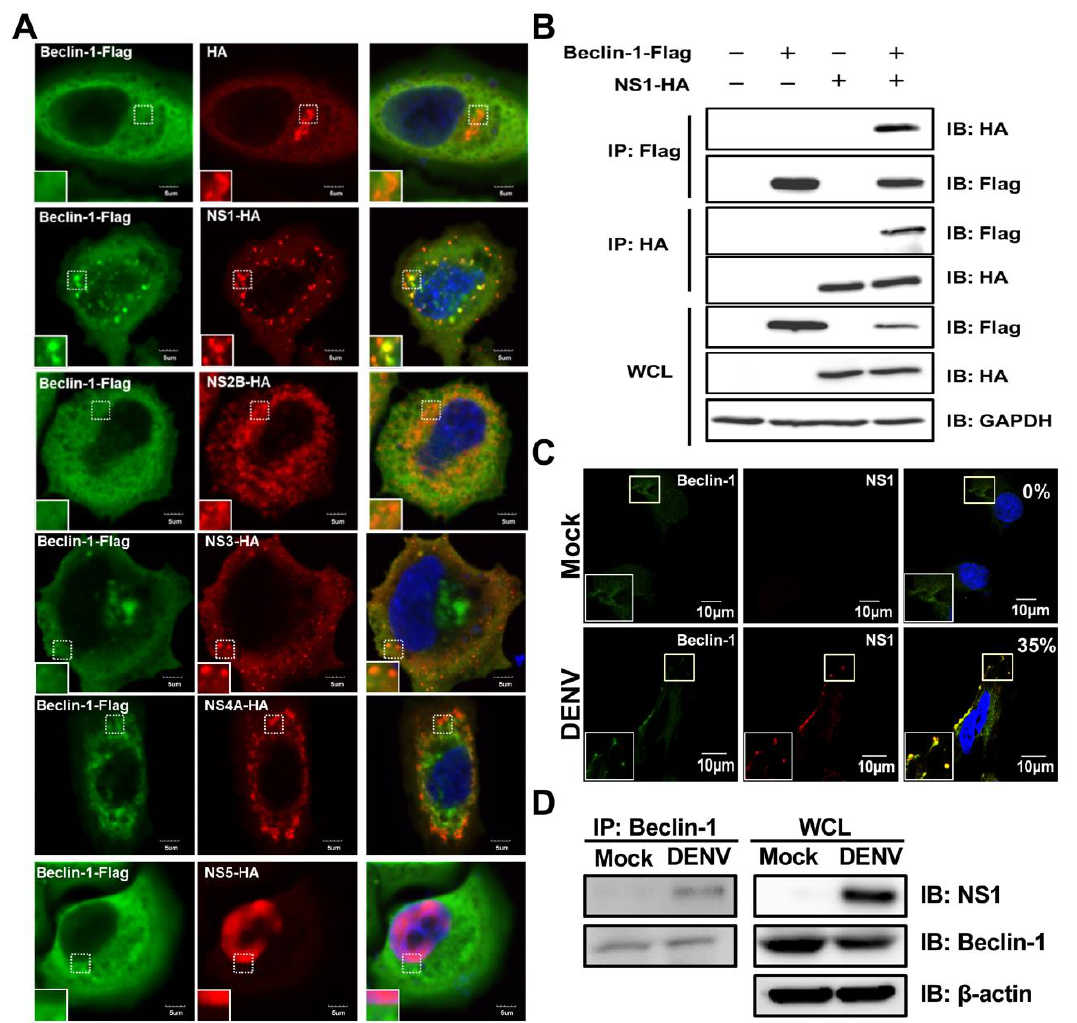
Figure 4. The colocalization and interaction of DENV NS1 with Beclin-1 are found in NS1-expressing and DENV-infected cells. ( A ) Hela cells were co-transfected with NS plasmids (including HA, NS1-HA, NS2B-HA, NS3-HA, NS4A-HA or NS5-HA) and Belcin-1-Flag plasmids for 48 h. At 48 h post-transfection, cells were fixed, permeabilized, and stained with anti-HA Abs (green), anti-Flag Abs (red) and DAPI (blue). Cells were mounted and observed by confocal microscopy. The square insets show higher magnification. Scale bar: 5 µ m. ( B ) Hela cells were co-transfected with NS1-HA and Belcin-1-Flag plasmids for 48 h. Cells were lysed and the cell lysates were immunoprecipitated by anti-Flag Abs followed by immunoblotting using anti-HA and anti-Flag Abs. The whole cell lysate (WCL) was used as the protein control. ( C ) A549 cells were infected with DENV at MOI = 2 for 24 h. At 24 h post-infection, cells were fixed, permeabilized, and stained with anti-NS1 Abs (green), anti-Beclin-1 Abs (red) and DAPI (blue). Cells were mounted and observed by confocal microscopy. The square insets show higher magnification. Percentages of colocalized dots of NS1-Beclin-1 complex were indicated in the upper right corner. Scale bar: 10 µ m. ( D ) Cells were lysed and the cell lysates were immunoprecipitated by anti-Beclin-1 Abs followed by immunoblotting using anti-NS1 and anti-Beclin-1 Abs. The whole cell lysate (WCL) was used as the protein